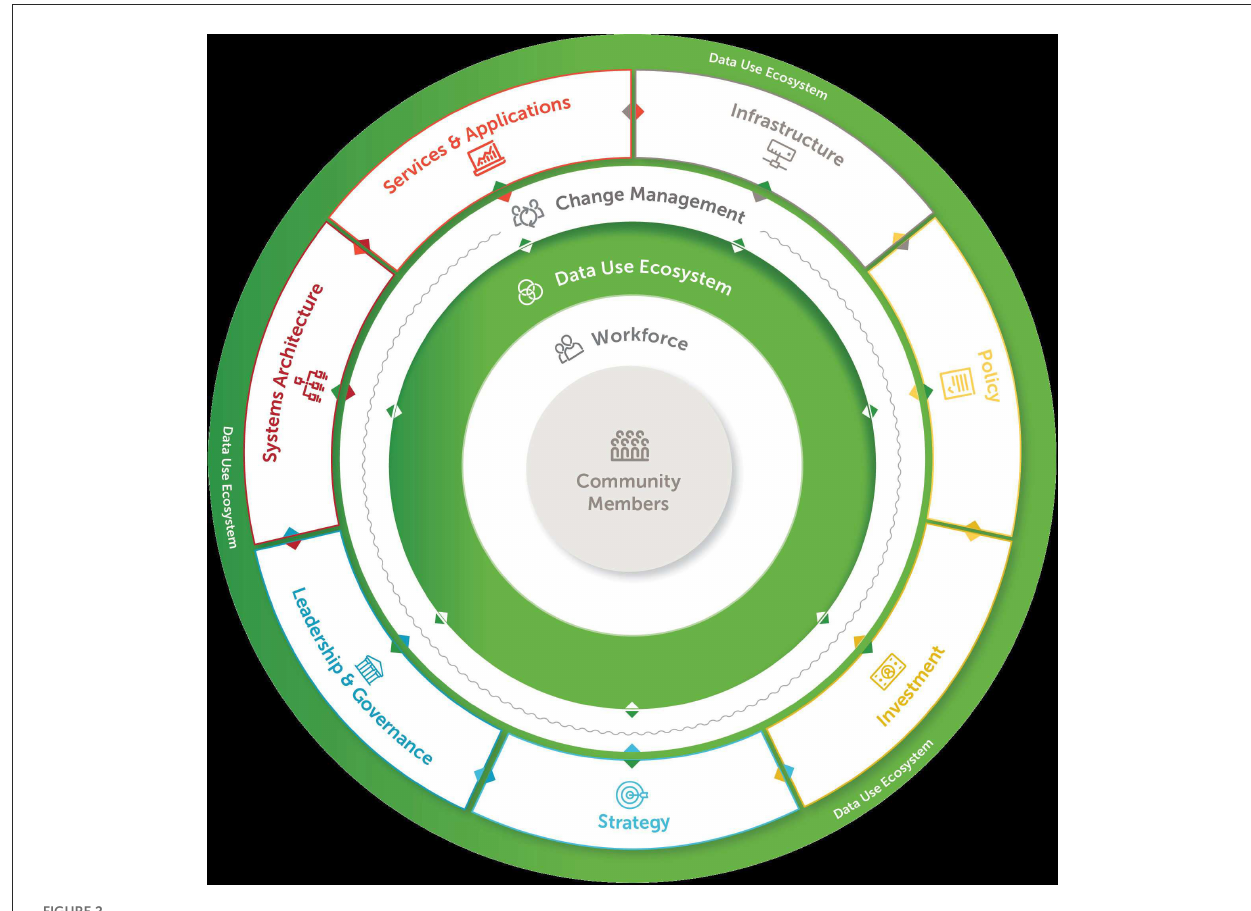
FIGURE2 The data use acceleration and learning (DUAL) model.